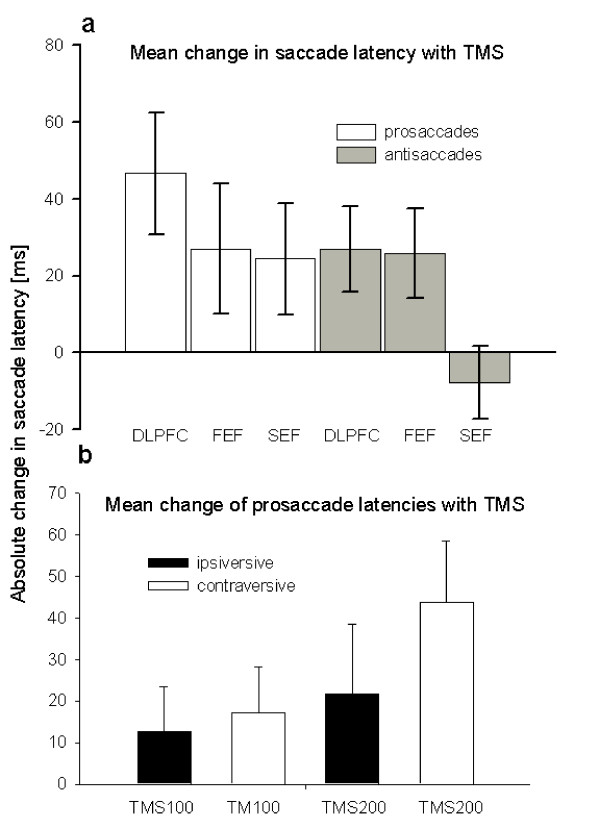
(a) Overall mean change (± SEM) in saccade latencies: the increase of saccadic latencies induced by TMS to the DLPFC, FEF, and SEF during the prosaccade and antisaccade task relative to trials without any TMS. Mean latencies of ipsi- and contraversive prosaccades and trials with TMS at 100 and 200 ms after gap period onset are pooled together to demonstrate the main effect of the site of TMS. (b) Changes (mean ± SEM) in saccade latencies of ipsiversive and contraversive prosaccades caused by TMS applied at 100 and 200 ms after gap period onset. The data obtained with TMS over DLPFC, FEF, and SEF are pooled together to illustrate the overall influence of timing of TMS on saccade latencies.